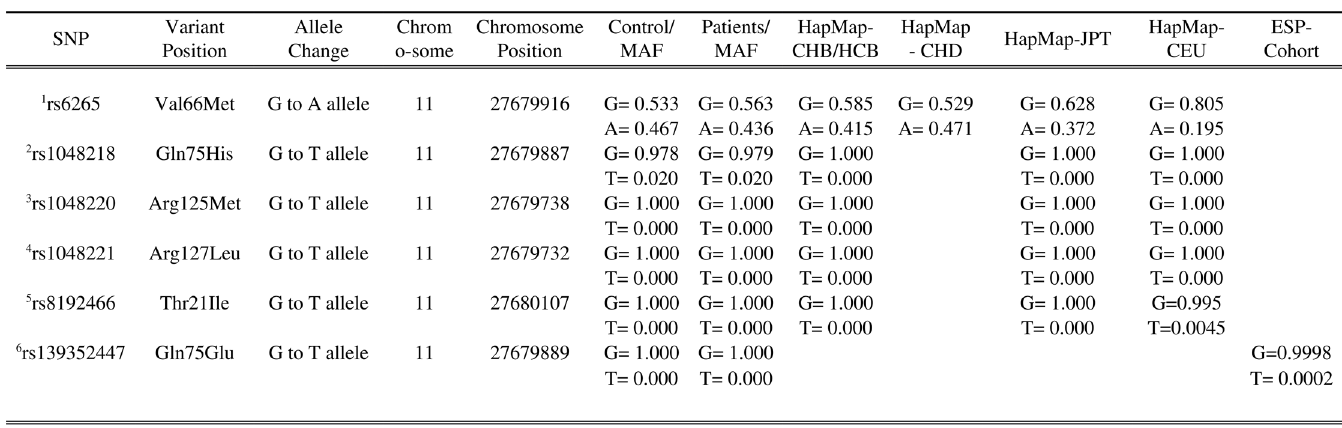
Fig 1. List of BDNF SNPs studied, chromosome position, minor allele frequencies and genotyping quality control values of study healthy subjects, patients with mTBI and comparative haplotype groups. Abbreviation: MAF, Minor Allele Frequency; HapMap, Haplotype Map; CHB/HCB, Han Chinese of Beijing; CHD, Han Chinese of Denver, JPT, Japanese of Tokyo; CEU,Northern and Western European Ancestry, Utah; ESP-Cohort, Exome Sequencing Project Cohort. 1 Reference minor allele frequency as reported in http://www.ncbi.nlm.nih.gov/projects/SNP/snp_ref.cgi?rs=6265. 2 Reference minor allele frequency as reported in http://www.ncbi.nlm.nih.gov/projects/SNP/snp_ref.cgi?rs=1048218. 3 Reference minor allele frequency as reported in http://www.ncbi.nlm.nih.gov/projects/SNP/snp_ref.cgi?rs=1048220. 4 Reference minor allele frequency as reported in http://www.ncbi.nlm.nih.